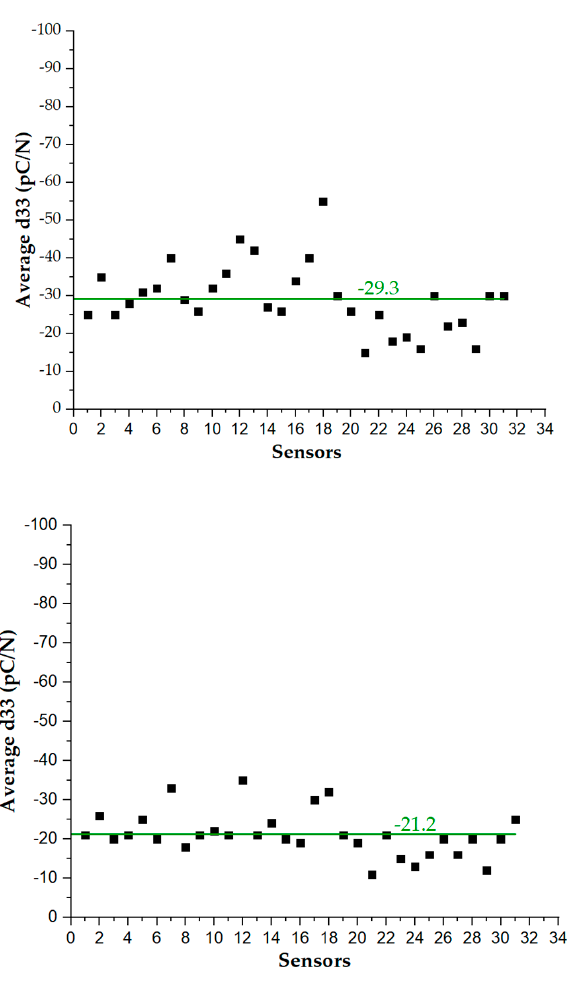
Figure 16. Average d 33 for each sensor at PL = 1 N ( top ), 2 N ( middle ) and 3 N ( bottom ).